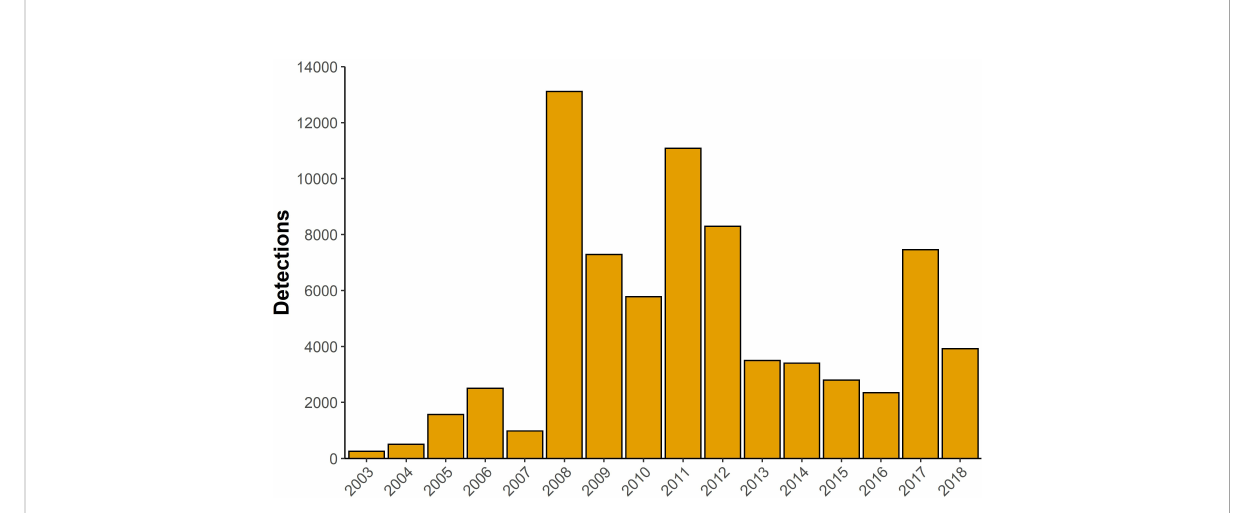
FIGURE 2 Total yearly number of eastern Indian Ocean (EIO) pygmy blue whale calls detected between 2003 and 2018 at Cape